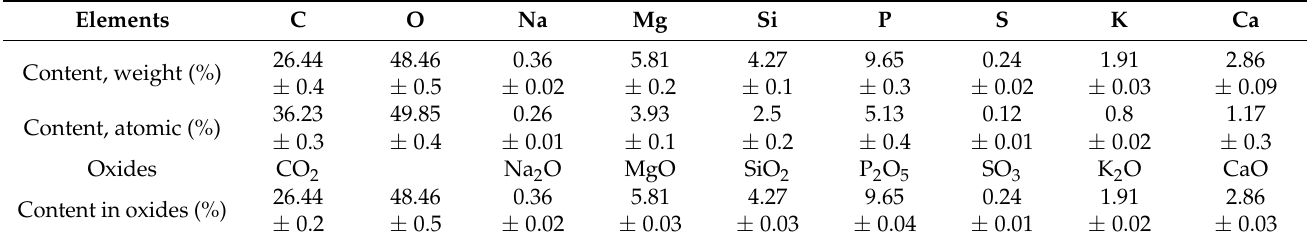
Figure 3. The EDS spectrum of brewer’s grains. Table 1. Elemental composition of BG waste (EDS microanalyser).